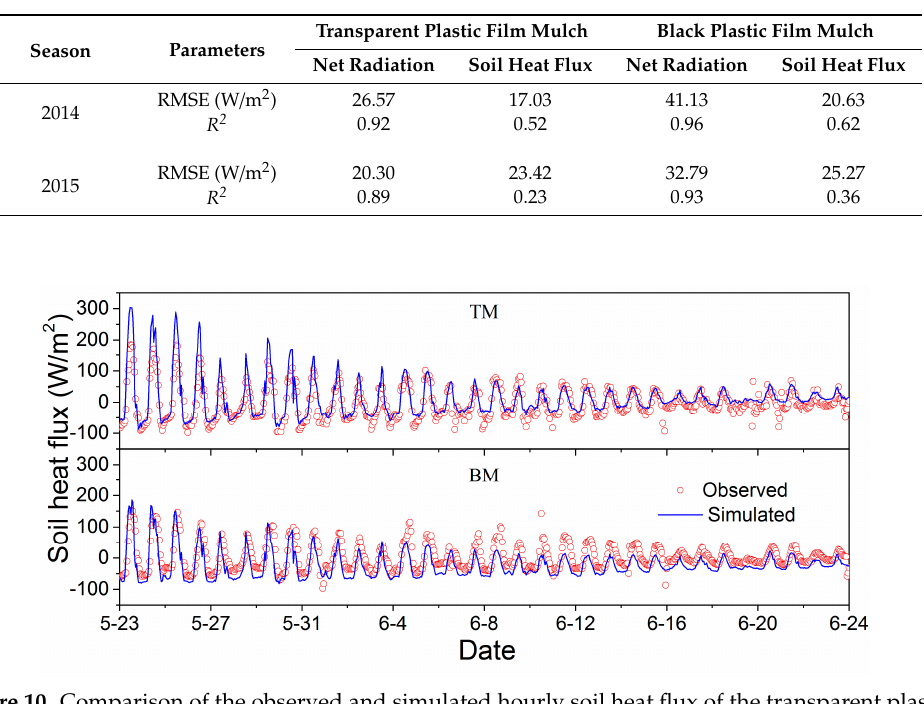
Table 7. The root mean square errors (RMSE) and coefficient of determination ( R 2 ) in simulated and observed daily net radiation and soil heat flux for the transparent plastic film mulch and black plastic film mulch treatments at Wuwei, China.